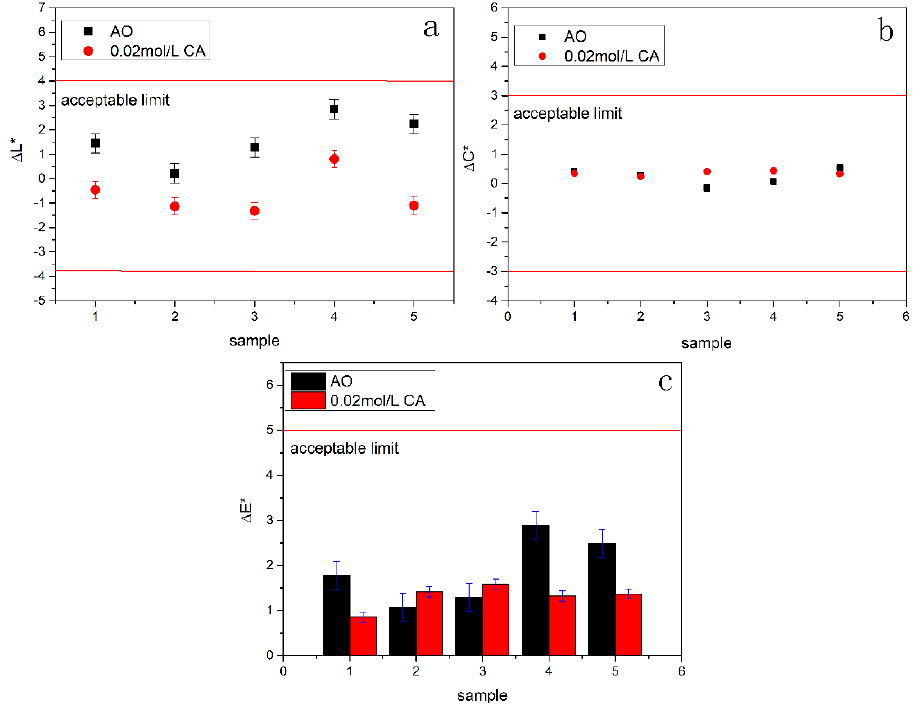
Figure 8. Chromatic change in sample: ( a ) Δ L * value, ( b ) Δ C * value, ( c ) Δ E * value.